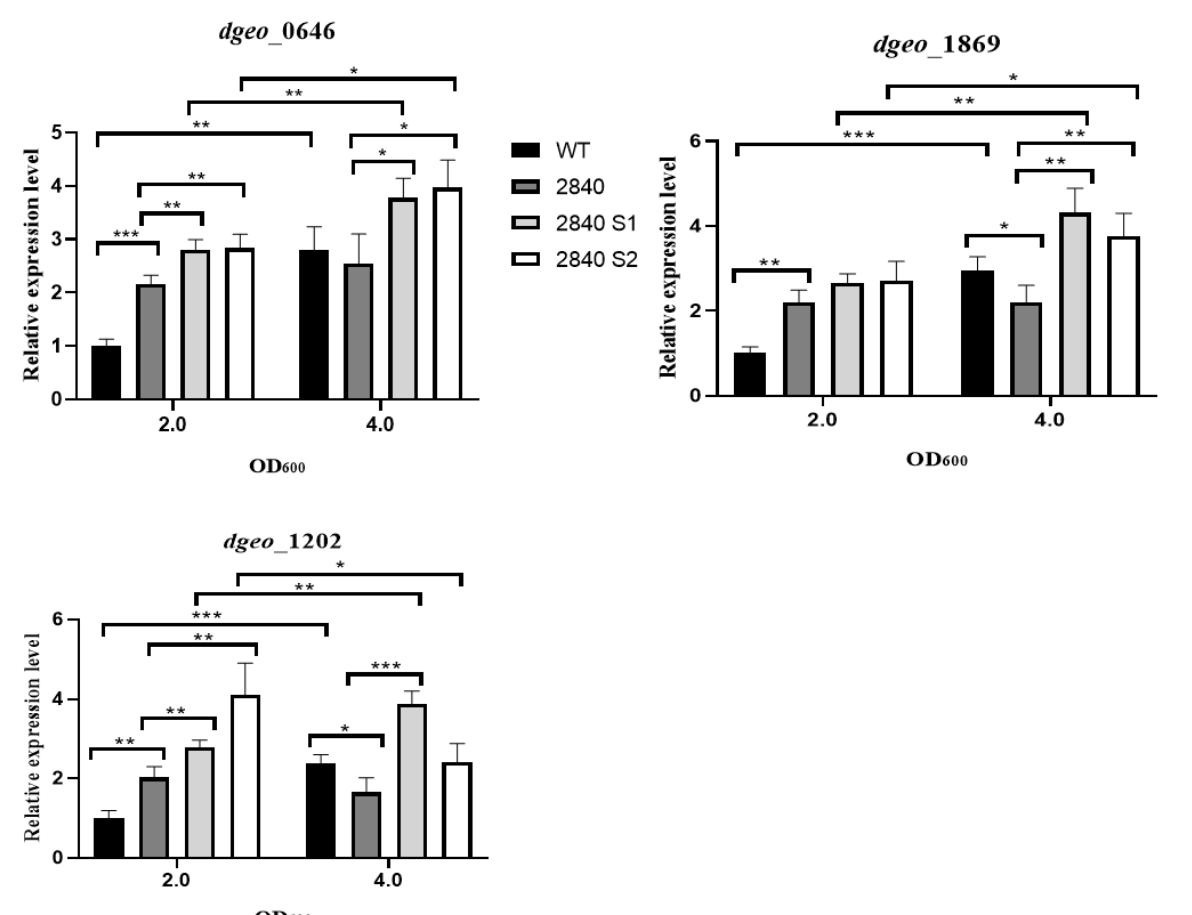
Figure 6. qRT-PCR for Sm-enhanced clone growth of ∆ dgeo _2840 parent and two SmD strains (S1 and S2) with the wild type at OD 600 of 2.0 and 4.0. dgeo _0646 and dgeo _1869 are EF-Tu genes ( tufA and tufB , respectively), and dgeo _1202 is a putative aadA gene. The statistics were performed with a probability t -test in the Prism program with p < 0.05 (*), p < 0.001 (**), and p < 0.0001 (***).